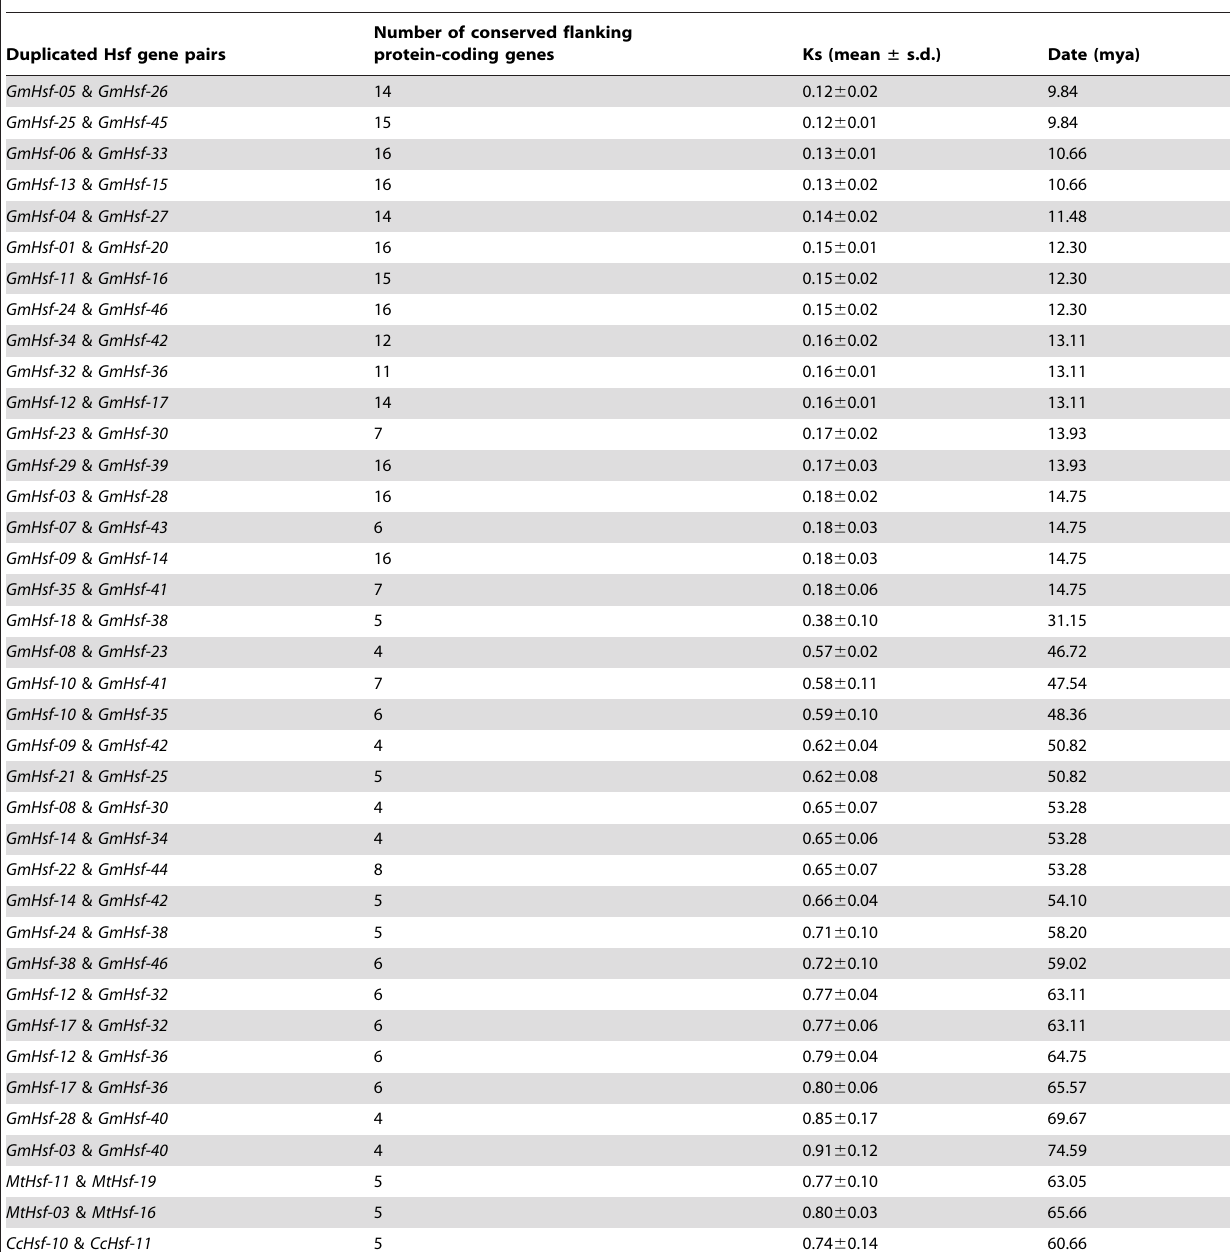
Table 2. Estimates of the dates for the large scale duplication events in legume species.